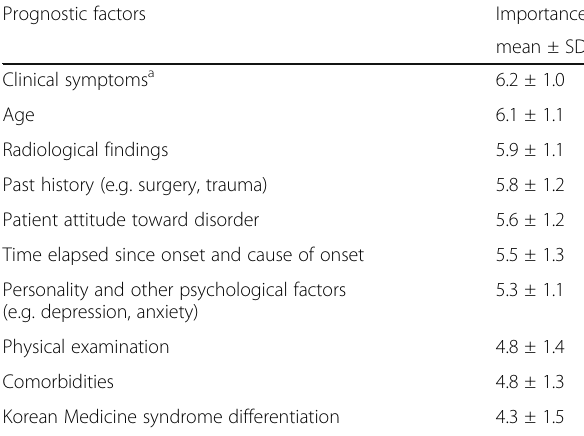
Table 5 Prognostic factors regarding LSS Prognostic